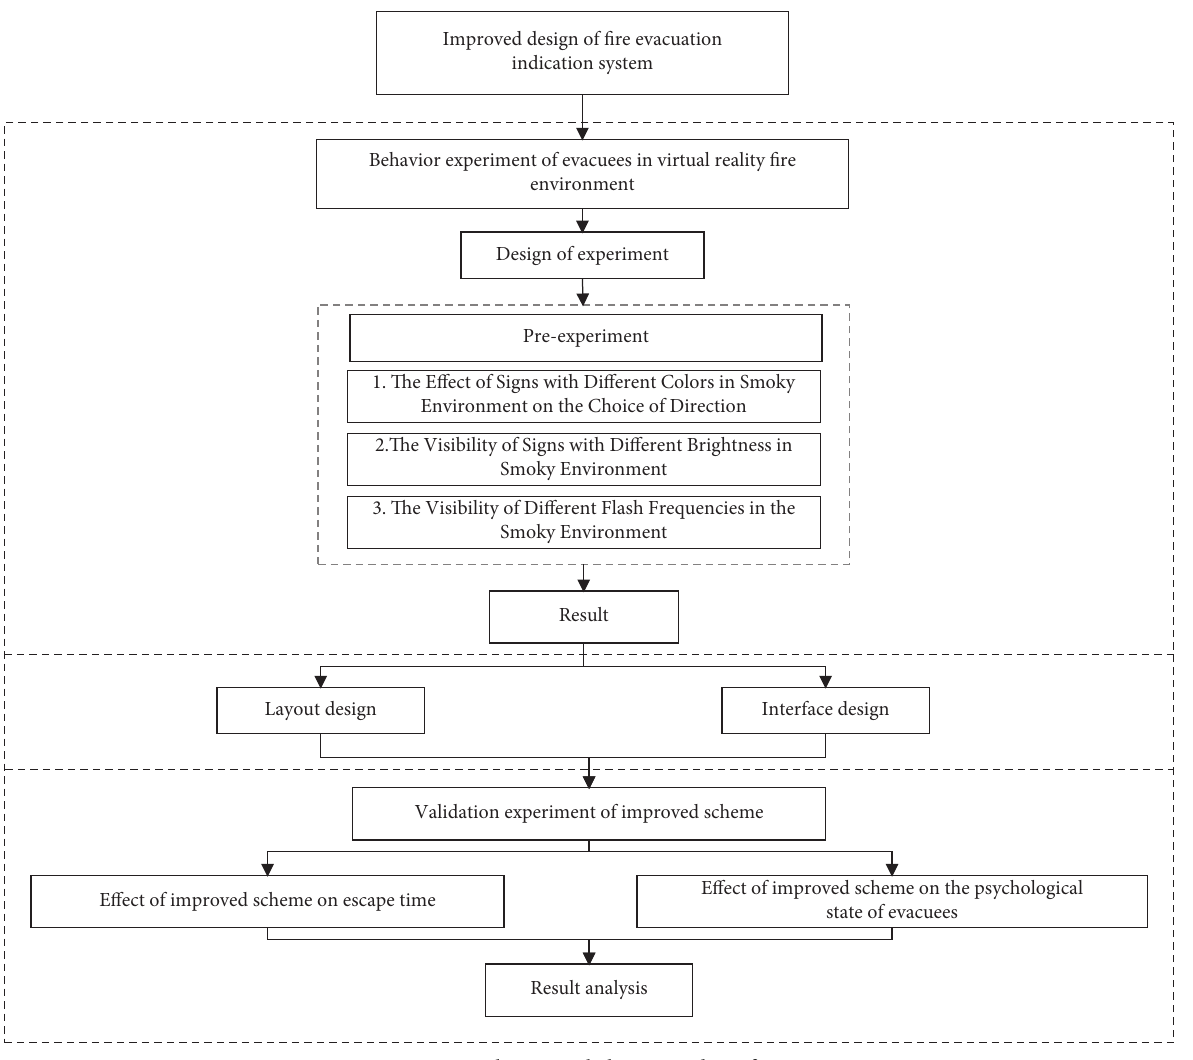
Figure 1: Experimental evacuee behavior and verification